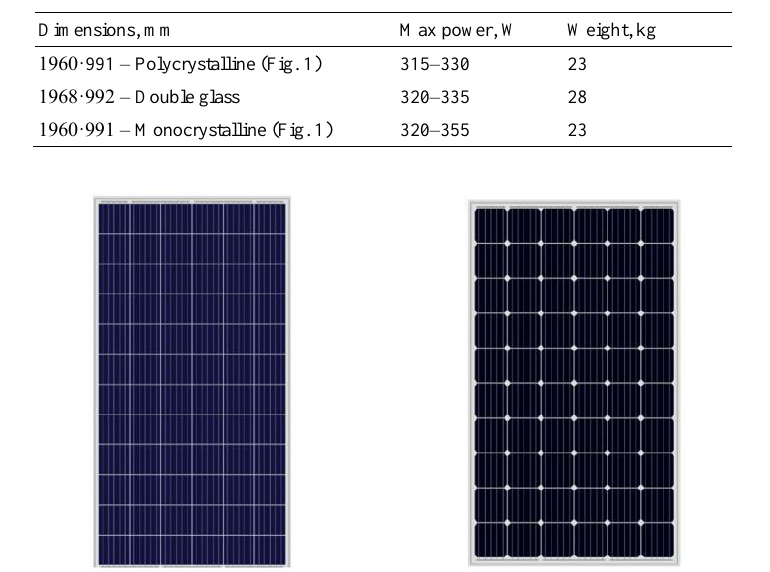
Fig. 1. Polycrystalline and Monocrystalline solar panel